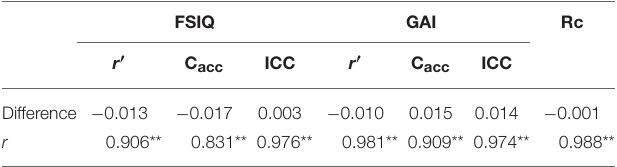
TABLE 3 | Comparison the principal indexes of reliability and validity estimated with our sample and the simulated dataset. FSIQ GAI